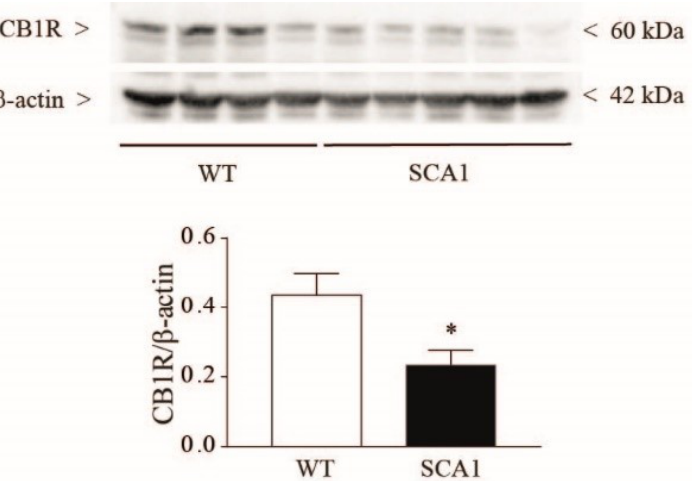
Figure 4. Reduced CB1R protein levels in the hippocampus of 8-week-old SCA1 mice. Hippocampal protein levels of CB1 receptors. Values are means ± S.E.M. of 4–5 mice. * p < 0.05 vs. wild-type mice (Student’s t-test); t 7 = 2.413.